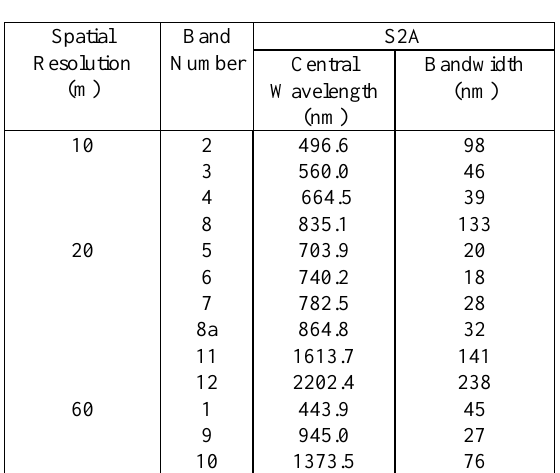
Table 2. Properties of SENTINEL-2A image, acquisition date 9